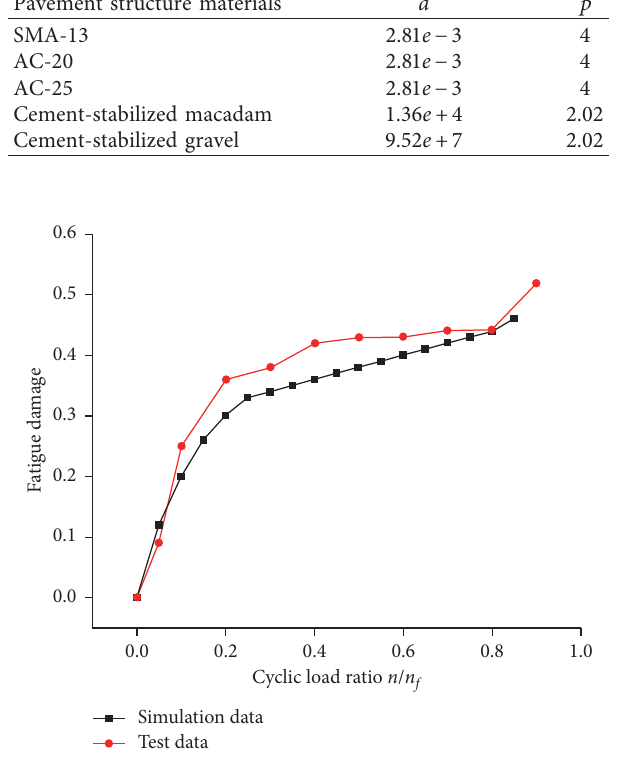
Figure 1: Comparison of results of fatigue damage accumulation curves of cement-stabilized